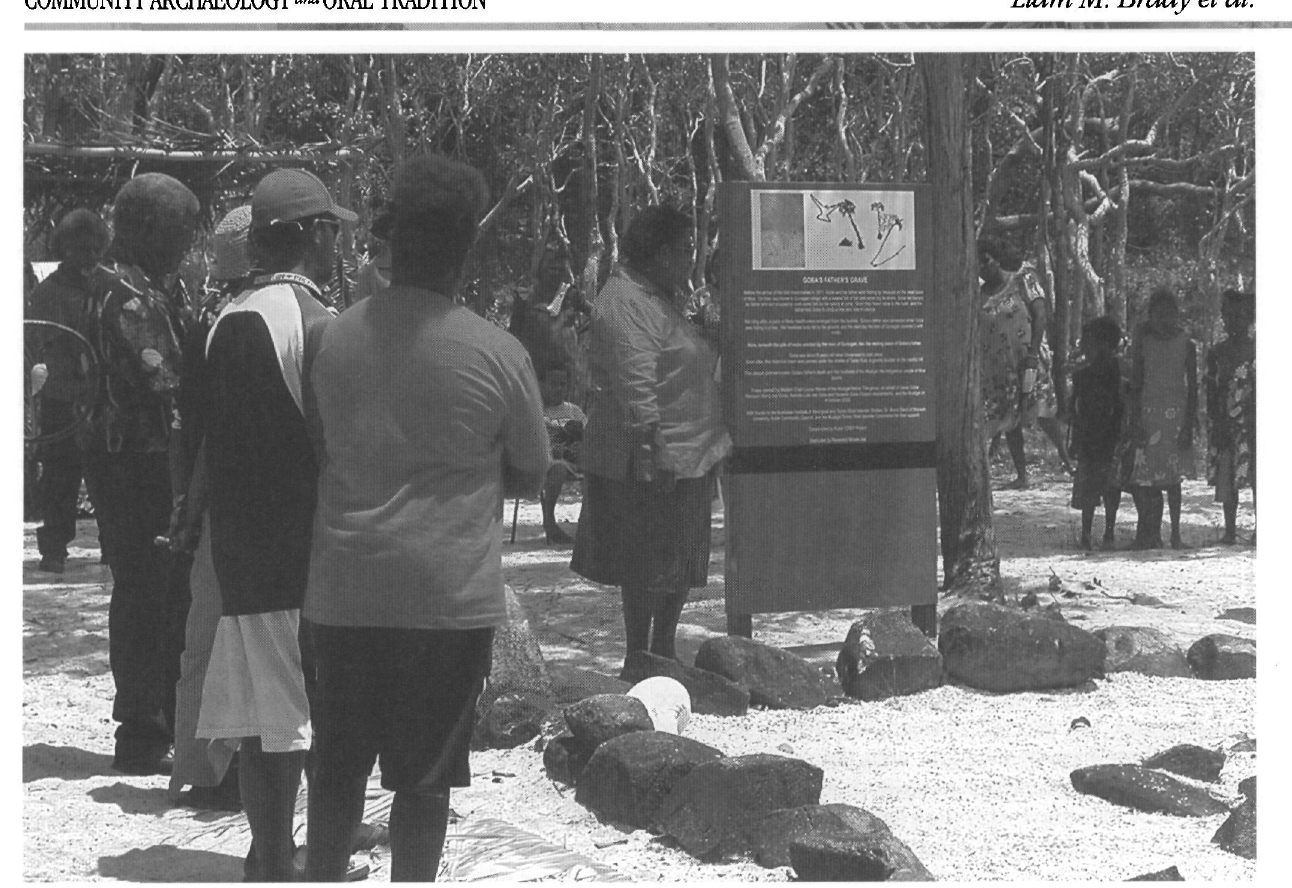
Figure 3- The plaque during the celebrations at Goba's father's grave at